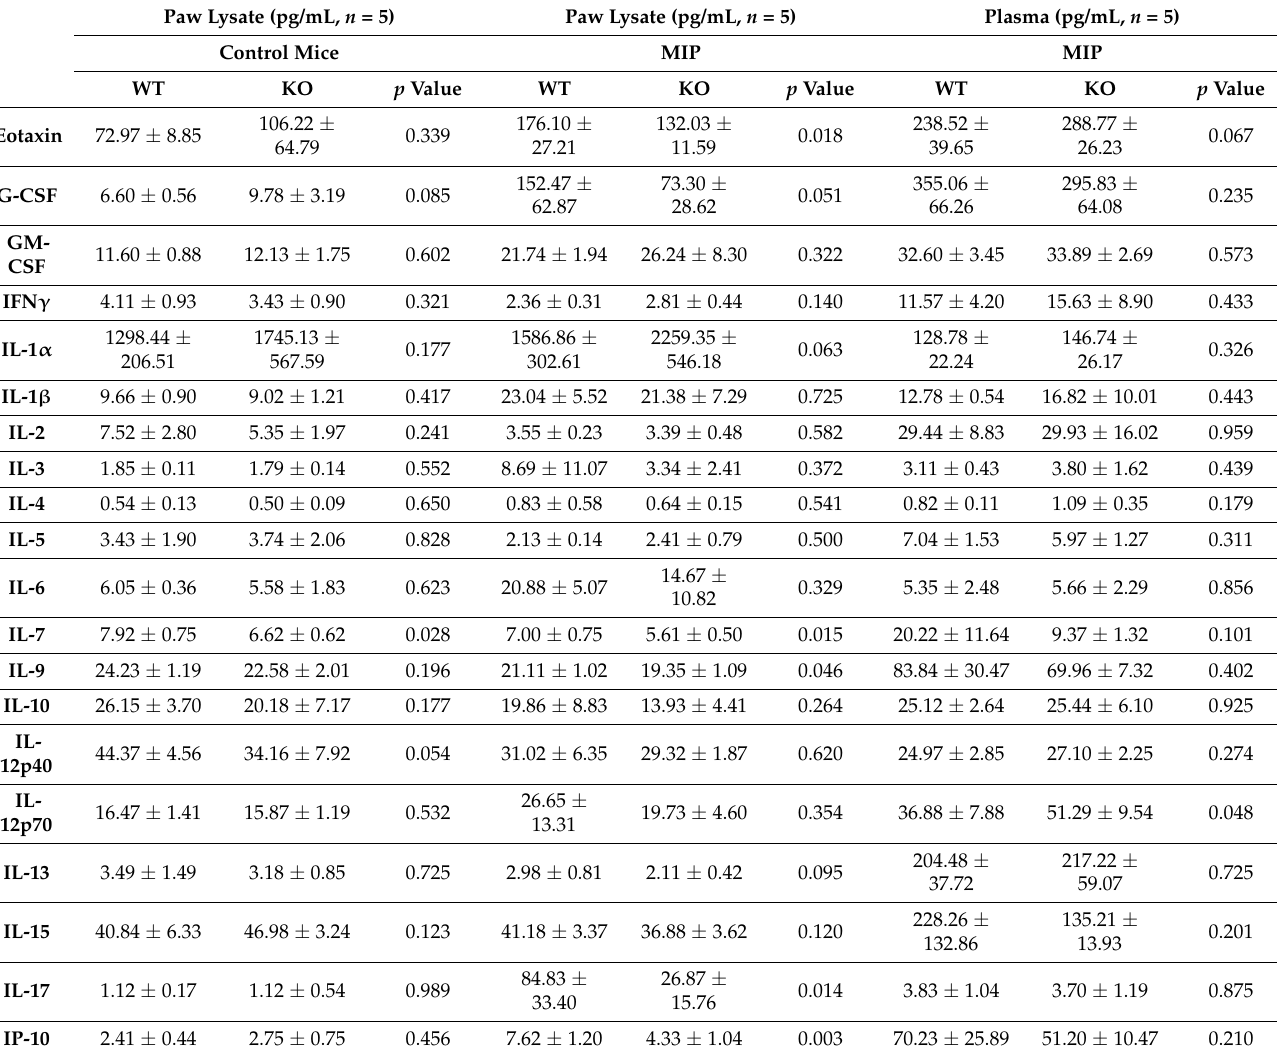
Table 1. Cytokine/chemokine levels in paw lysates and plasma